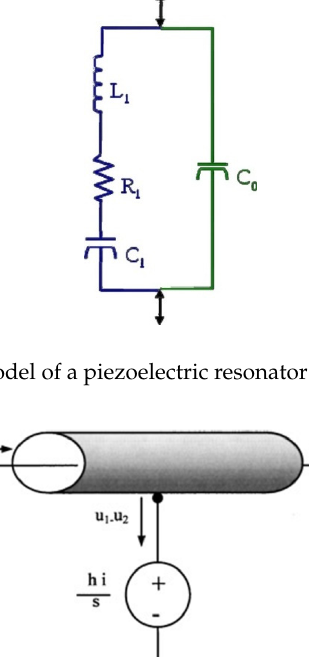
Figure 11. PSPICE schematic, which describes the equivalent circuit of a given device (under simulation) using a single piezoelectric element, represented by the lossy transmission line.